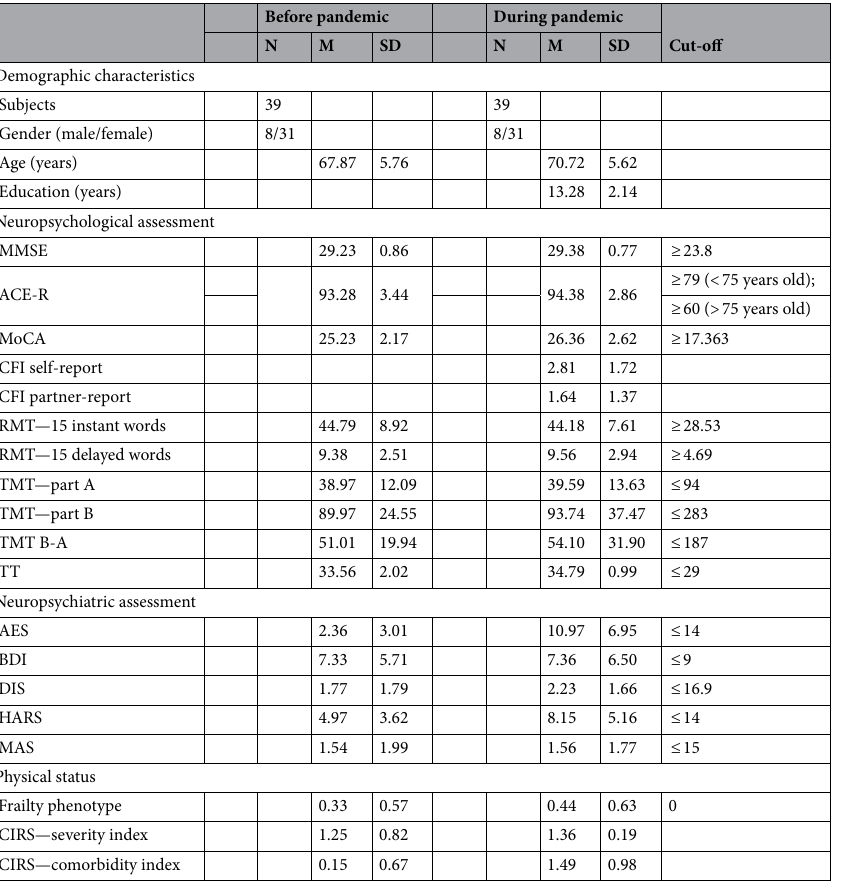
Table 2. Demographic and neuropsychological characteristics of study participants before and during the pandemic. N number, M mean, SD standard deviation, MMSE Mini Mental State Examination, ACE- R Addenbrooke’s cognitive examination—revised version, MoCA Montreal cognitive assessment, CFI cognitive functional instrument, RMT Rey memory test, TMT trail making test, TT token test, AES Apathy Evaluation Scale, BDI Beck Depression Inventory, DIS Disinhibition Scale, HARS Hamilton Rating Scale for Anxiety, MAS Mania Scale, CIRS Cumulative Illness Rating